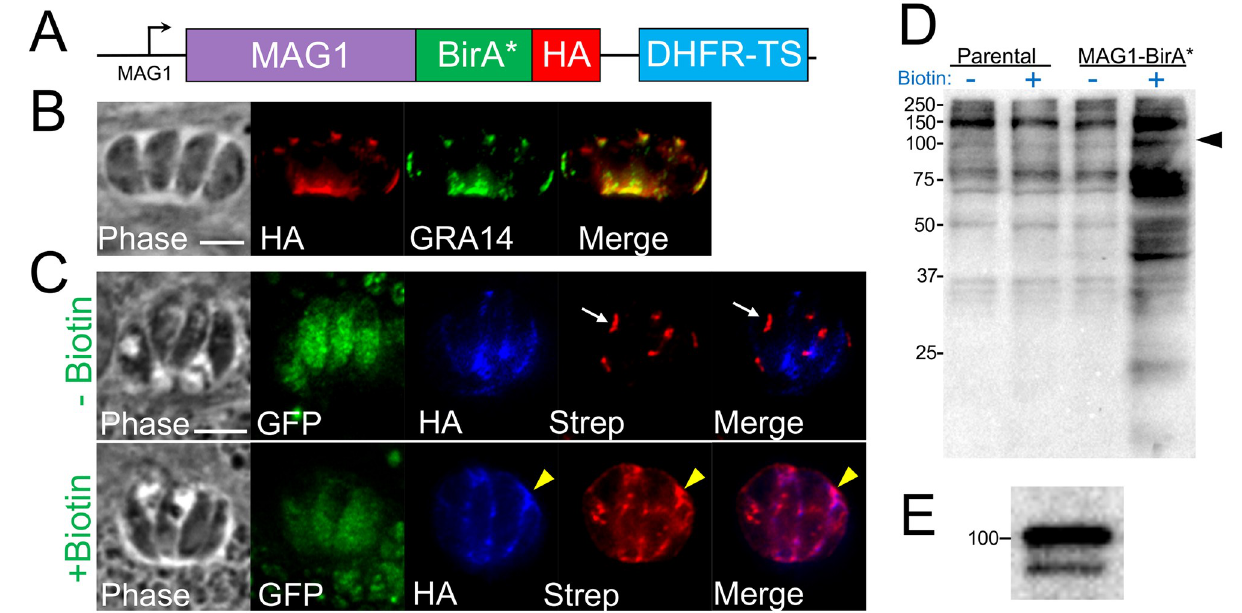
Fig 1. MAG1-BirA � localizes to the PV and biotinylates proteins in the cyst vacuole. (A) Diagram of the construct encoding the promoter and full genomic sequence of MAG1 fused to BirA � along with a 3xHA C-terminal epitope tag. (B) IFA of MAG1-BirA � showing that the fusion protein appropriately traffics to the tachyzoite PV and colocalizes with the known protein GRA14. Scale bar: 5 μ m (applicable to all panels). (C) IFA of MAG1-BirA � -expressing parasites, showing the bradyzoite PV is labeled in a biotin-dependent manner (yellow arrowheads, +Biotin row). Endogenously biotinylated apicoplasts are observed with and without biotin (white arrows, -Biotin row). Scale bar: 5 μ m (applicable to all panels in C). (D) Western blot of whole-cell lysates of parental (Prugniaud Δ ku80 Δ hxgprt ) and MAG1-BirA � -expressing parasites -/+ biotin. Lysates were probed with streptavidin-HRP, revealing an increase in biotinylated proteins in MAG1-BirA � -expressing parasites upon addition of biotin. The MAG1-BirA � fusion protein is predicted to be ~105 kDa (arrowhead). (E) Western blot showing that MAG1-BirA � fusion migrates to ~105 kDa as detected by antibody against HA epitope